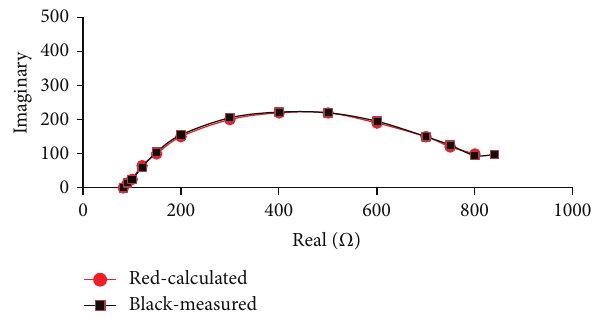
Figure 4: Comparison of the calculated and measured curve.